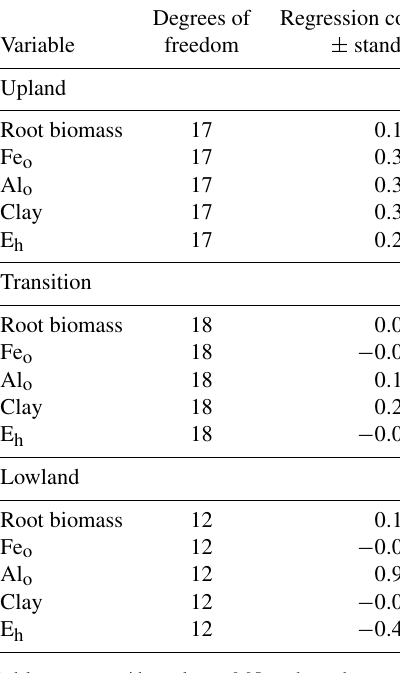
Table 4. Fixed-effect parameters from the linear mixed models along the upland–lowland transects. Degrees of Regression